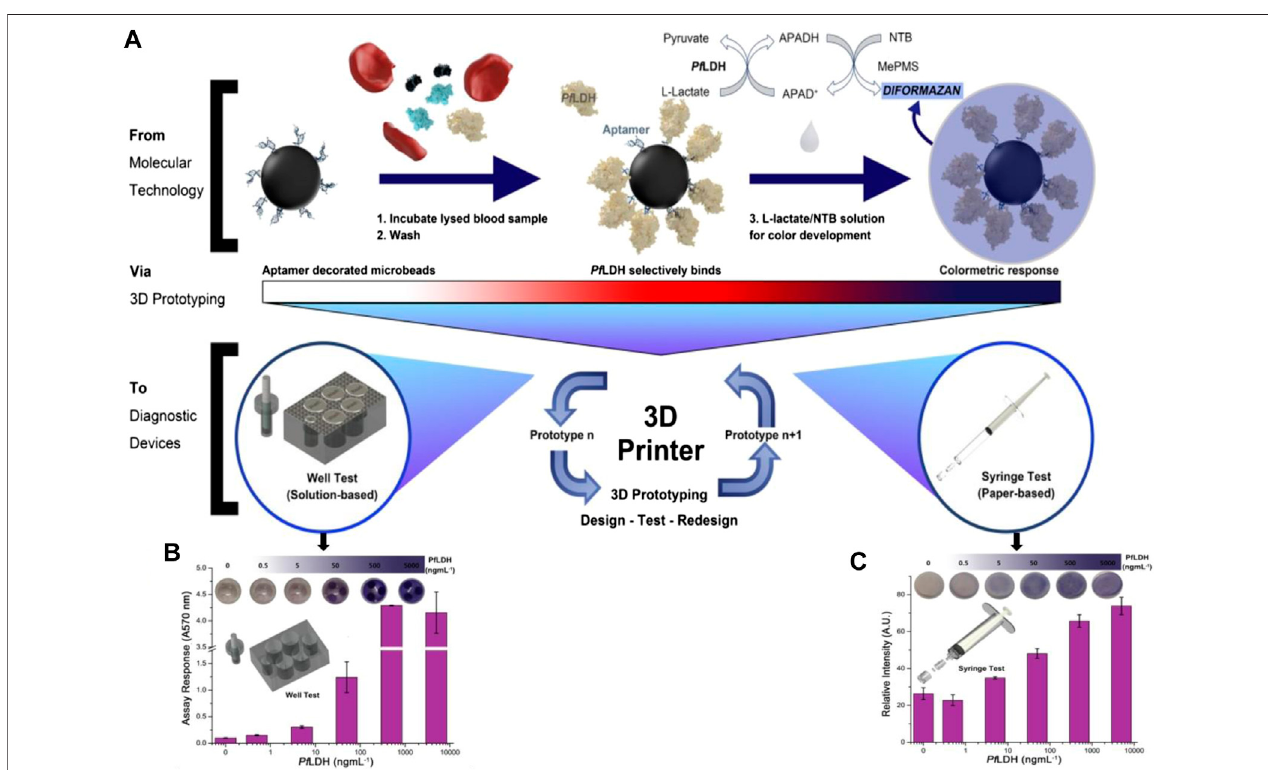
FIGURE 8 | (A) 96-well malaria-based assay (APTEC) was modi fi ed to microbead based assay for improved functionality. The assay functions using aptamer- functionalized microbeads to collect PfLDH from patient blood samples. The production reagent is applied after washing, which creates a blue response for malaria- positivesamples,usingtheenzymaticactivityofPfLDH. (B,C) TheresponseofprototypesofAPTECpoint-of-caredevicesusingdifferentPfLDHconcentrationsinserum samples (5% BSA) for the syringe test and well test which turns blue when positive. The response was quanti fi ed using absorbance (A570 nm) (reproduce with permission from Dirkzwager et al.,